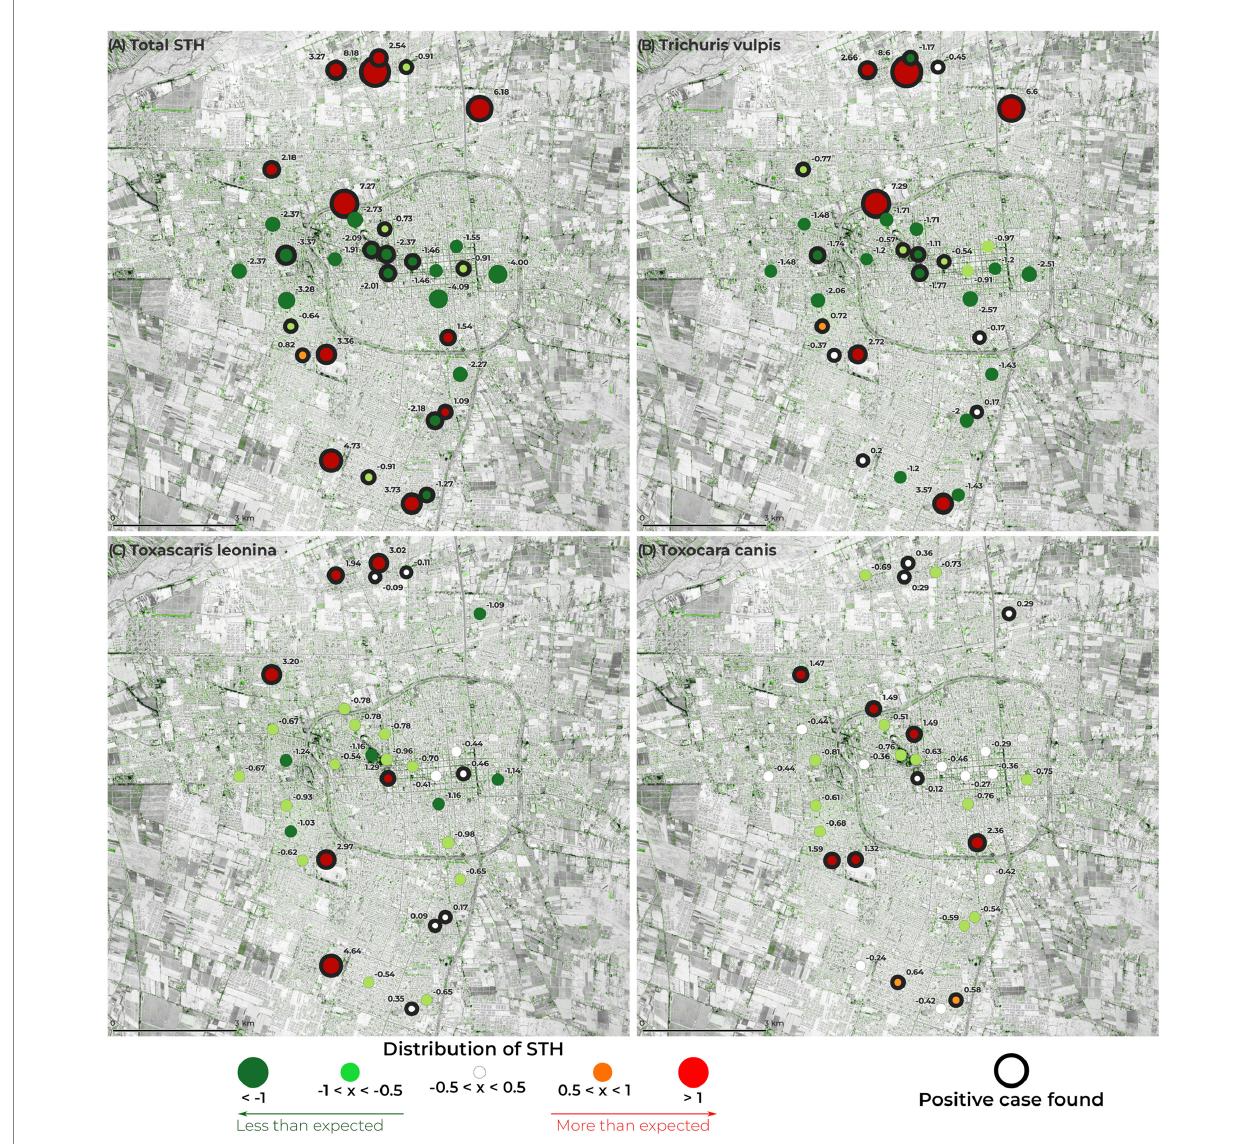
FIGURE 3 Distribution of canine soil-transmitted helminths (STH) in the study area of the city of San Juan (San Juan, Argentina). (A) Canine STH as a group. (B) Trichuris vulpis . (C) Toxascaris leonina . (D) Toxocara spp. Circles in red represent positive values where observed cases were higher than expected. Circles in green represent positive values where observed cases were less than the expected. In white, the difference between observed and expected values was not different. The circles with a black border represent those sites where positive samples were